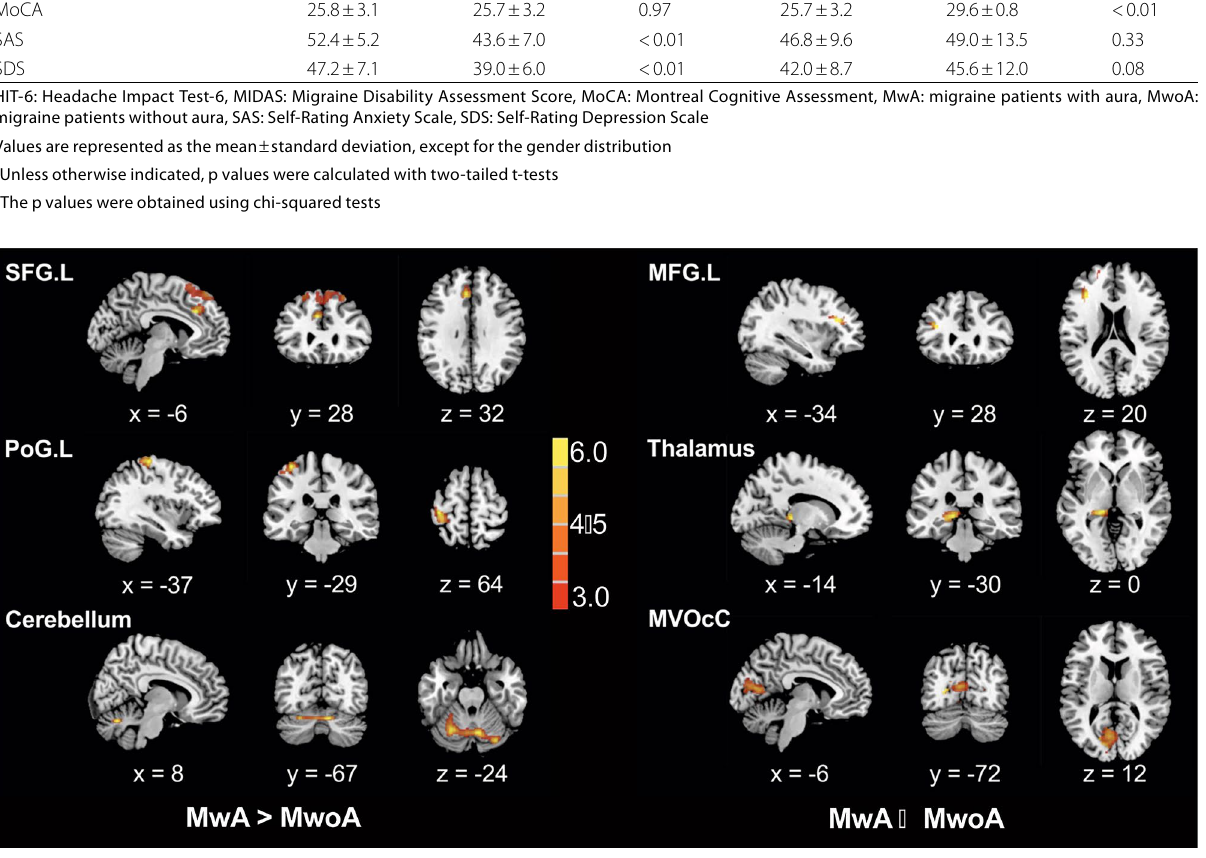
MwA in the MwoA in the training sample training sample (n = 32)